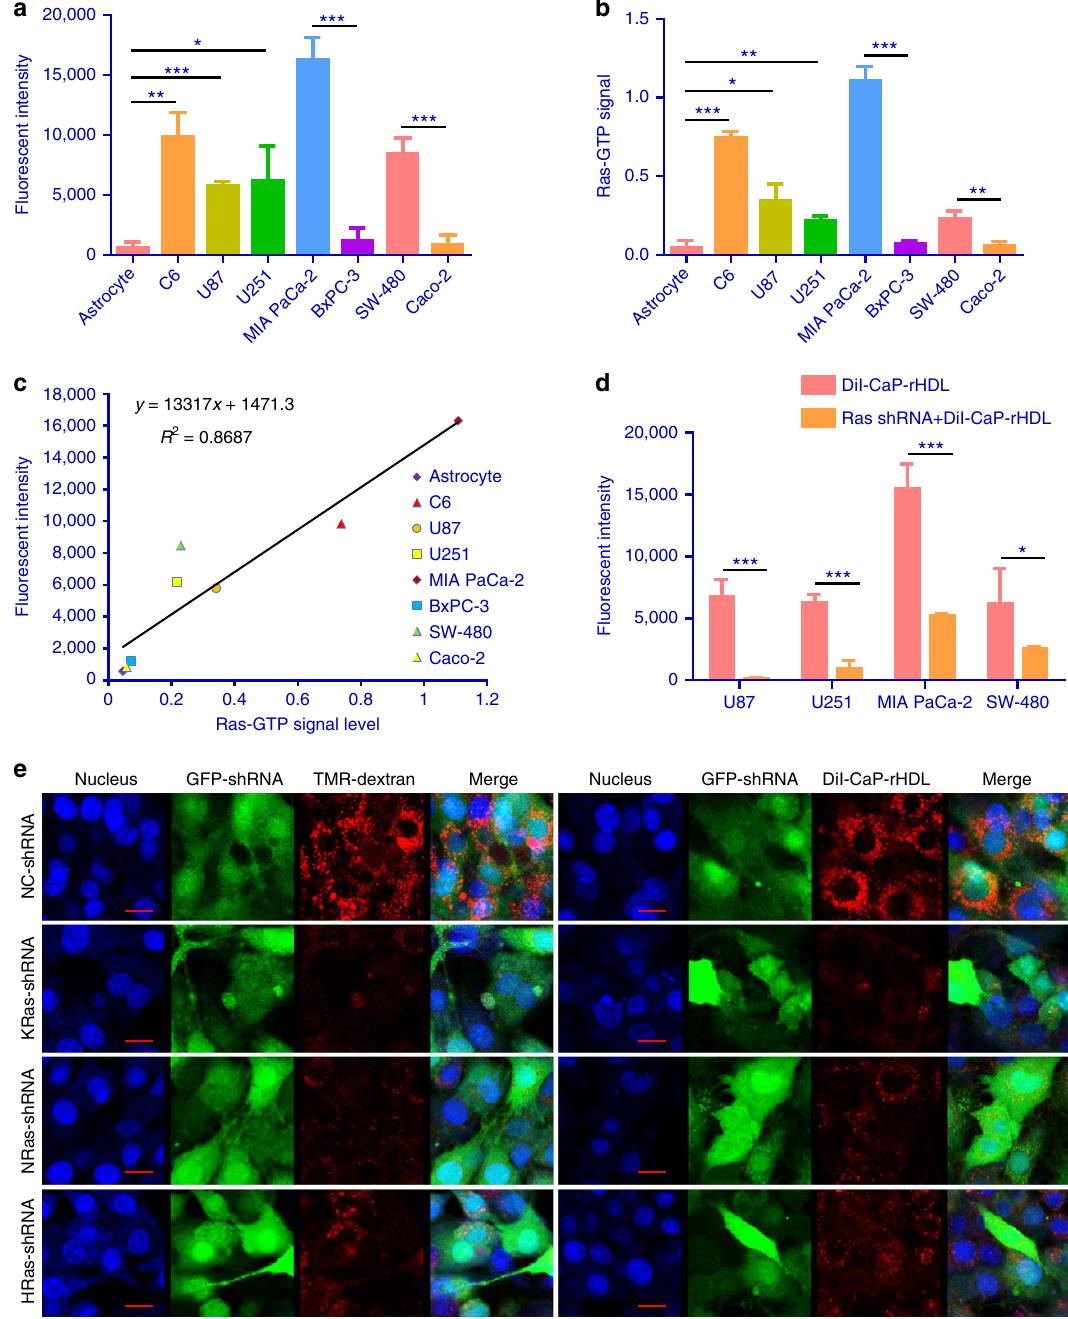
Figure 4 | Macropinocytosis-mediated cellular uptake of CaP-rHDL in a Ras activation-dependent manner. ( a ) Quantitative analysis of the cellular uptake of DiI-CaP-rHDL in astrocytes, C6, U87, U251, MIA PaCa-2, BxPC-3, SW-480 and Caco-2 cells after incubation at 37 (cid:2) C for 3h at the DMPC concentration of 5 m gml (cid:2) 1 . ( b ) The level of Ras-GTP in astrocytes, C6, U87, U251, MIA PaCa-2, BxPC-3, SW-480 and Caco-2 cells evaluated via a Ras activation assay kit. ( c ) A linear regression was established to model the relationship between the cellular uptake of CaP-rHDL and the intracellular Ras- GTP level in the different cell types ( R 2 ¼ 0.8687). ( d ) Knockdown of general all Ras led to a reduction in the cellular uptake of DiI-CaP-rHDL. Ras knockdown was achieved following the application of a shRNA expression lentivirus system. ( e ) Knockdown of each Ras-subtype led to a reduction in the cellular uptake of both the marker of macropinocytosis TMR-dextran and DiI-CaP-rHDL. Ras knockdown was achieved following the application of shRNA expression lentivirus systems. A comparable level of transfection efficiency between the various shRNAs was indicated by monitoring the intensity of green fluorescent protein (GFP), which is concomitantly expressed with each shRNA. Compared with that in those cells transfected with a negative control shRNA (NC-shRNA), the cellular uptake of TMR-dextran (red) and DiI-CaP-rHDL (red) were reduced in cells transfected with KRas-specific shRNA, NRas- specific shRNA and HRas-specific shRNA. Scale bar, 10 m m. For a , b and d , data represent mean ± s.d. ( n ¼ 3). The significance of the differences between two groups ( *P o 0.05, **P o 0.01, ***P o 0.001) was evaluated by two-tailed Student’s t